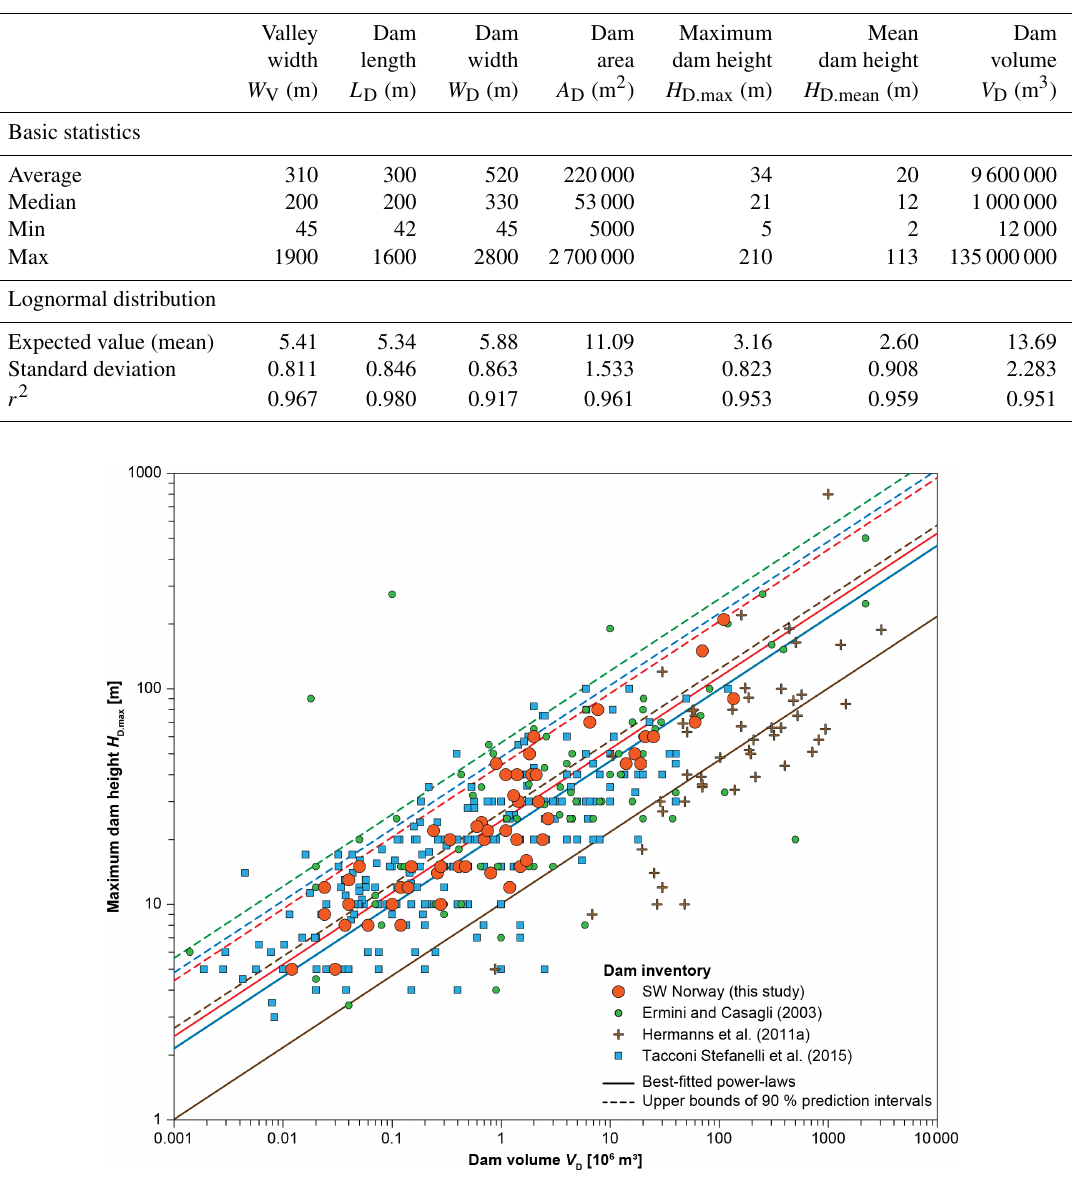
Figure 5. Relationship between maximum dam height H D . max and dam volume V D (10 6 m 3 ) for RSF dams in southwestern Norway (data from Jakobsen, 2015), compared to datasets from Ermini and Casagli (2003), Hermanns et al. (2011a), and Tacconi Stefanelli et al. (2015). The maximum dam heights increase with dam volume according to power-law distributions as in Eq. (2) with scale factors as in Table 2 (with colours matching the point